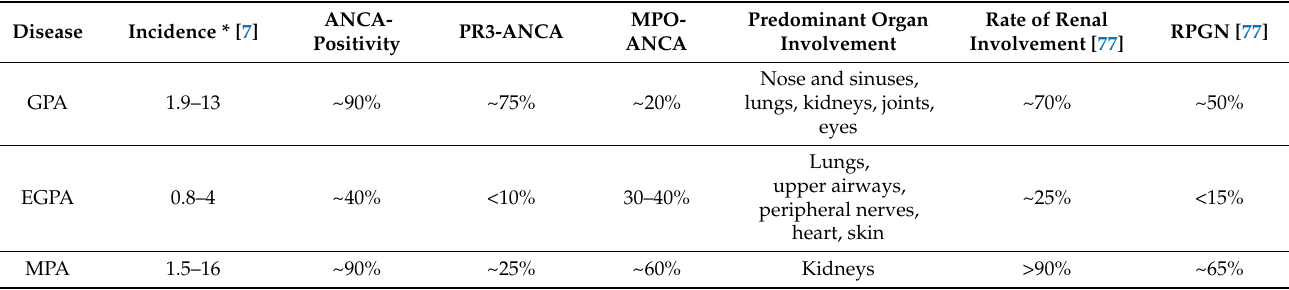
Table 1. Syndromes of